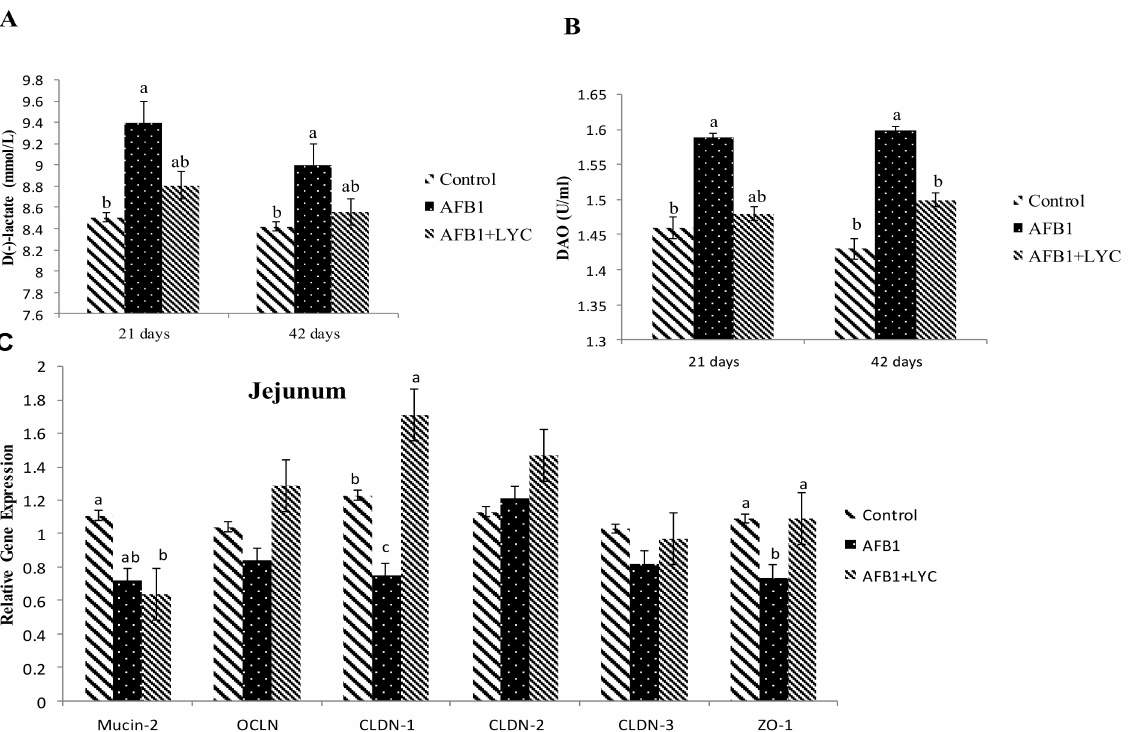
Figure 2. Effects of LYC on Serum D-lactate concentration ( A ) and diamine oxidase activities ( B ) in the broiler intestine fed AFB 1 contaminated diet at 21 and 42 d. ( C ) Effects of LYC on tight junction related gene expression in the jejunum of broiler intestine fed AFB 1 contaminated diets. The column and its bar represented the means and standard error of the means ( n = 6), respectively. abc Means with different superscript letters are significantly different ( p < 0.05). DAO, diamine oxidase; Mucin-2, mucins-2; OCLN, occludin; CLDN-1, claudin-1; CLDN-2, claudin-2; CLDN-3, claudin-3; ZO-1, zonula occludens-1; AFB 1 , AflatoxinB 1 ; LYC, Lycopene; and AFB 1 + LYC, (100 µ g/kg AFB 1 + 200 mg/kg